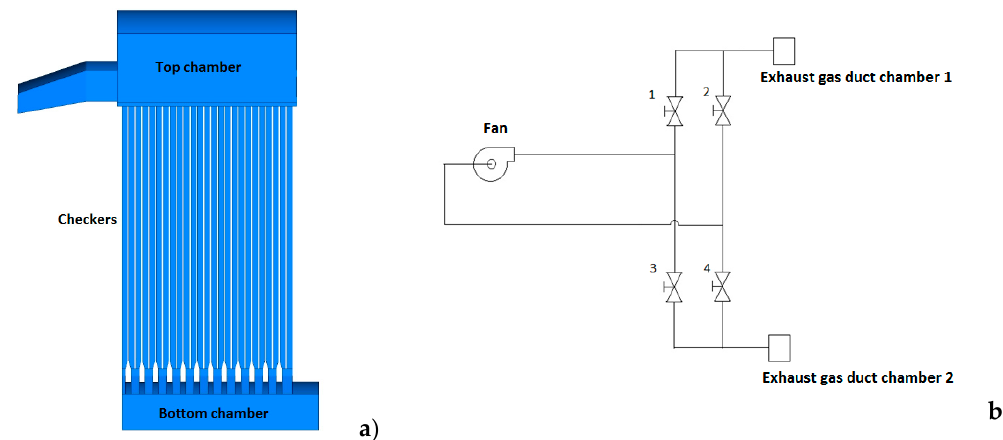
Figure 2. ( a ) Regenerative tower and ( b ) Waste Gas Recirculation (WGR) system scheme.